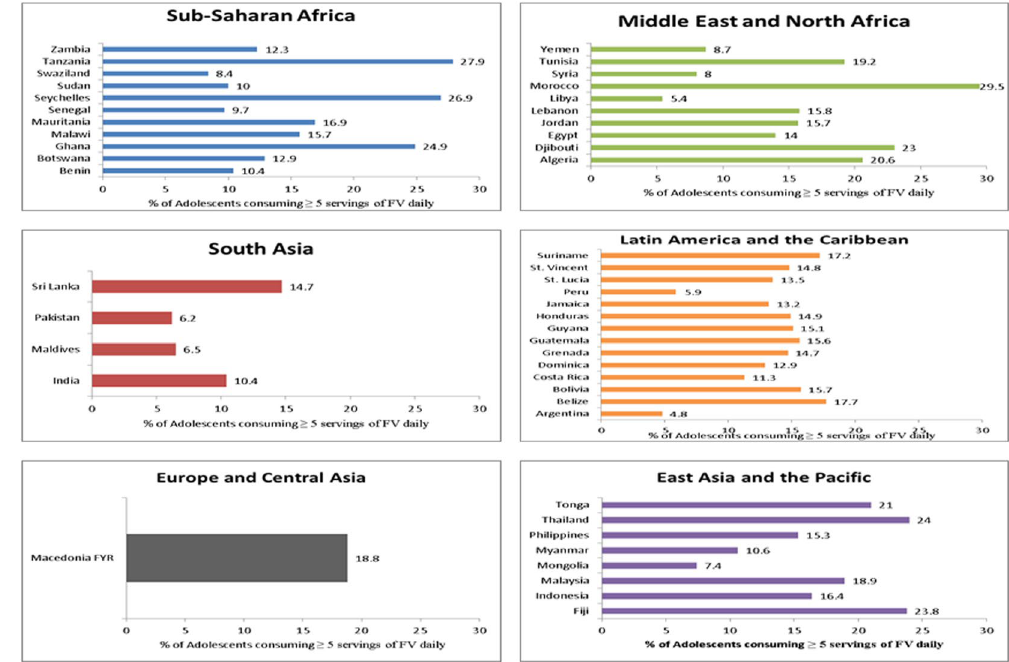
Figure 2. Percentage of adolescents meeting daily FV intake (5 servings) in LMICs grouped by World Bank regions.